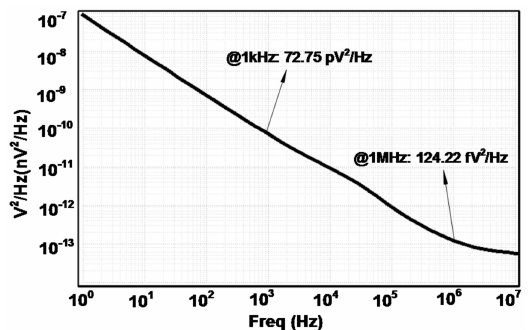
Figure 15. Noise simulation results of the analog parts of 1 channel from 1 Hz to 10